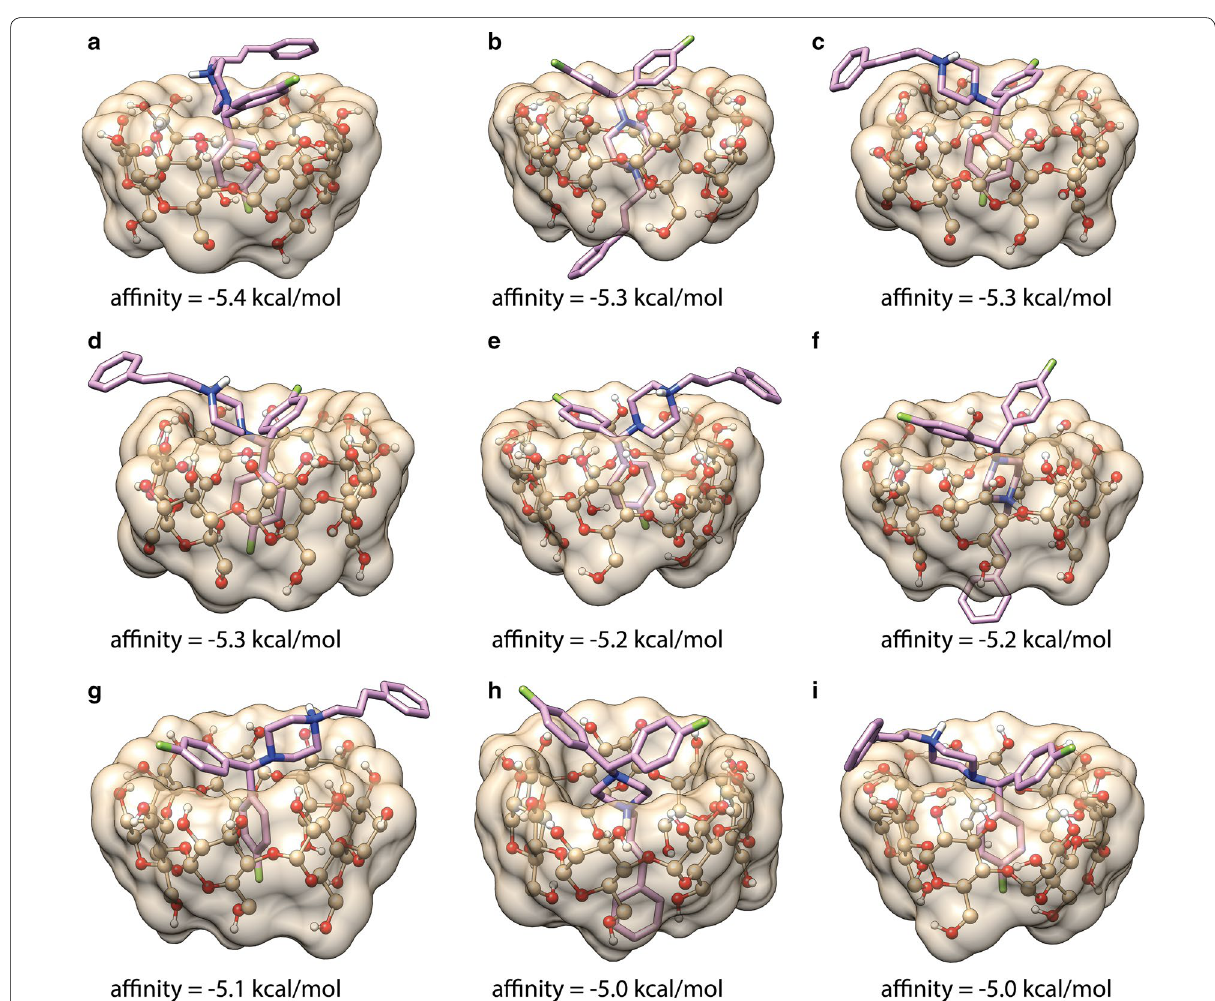
Fig. 4 a – i Different binding conformations obtained during FLN docked into β-CD cavity. The docking affinity is shown under the model. β-CD is shown as ball and stick with the surface while FLN is shown as stick bond. All atoms are shown in their elemental colour. Non-polar hydrogens are not shown for the sake of clarity. The figure was prepared using Chimera